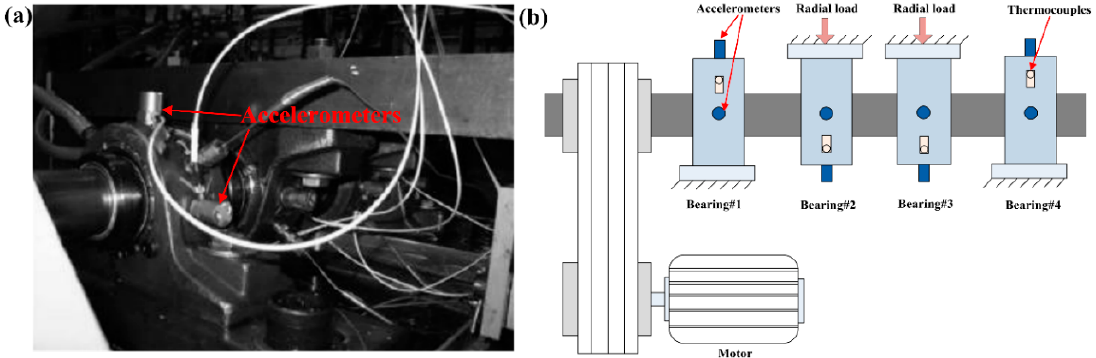
Figure 16. The bearing fault test bed from the Intelligent Maintenance System, University of Cincinnati, ( a ) The physical map; ( b ) The sketch map.